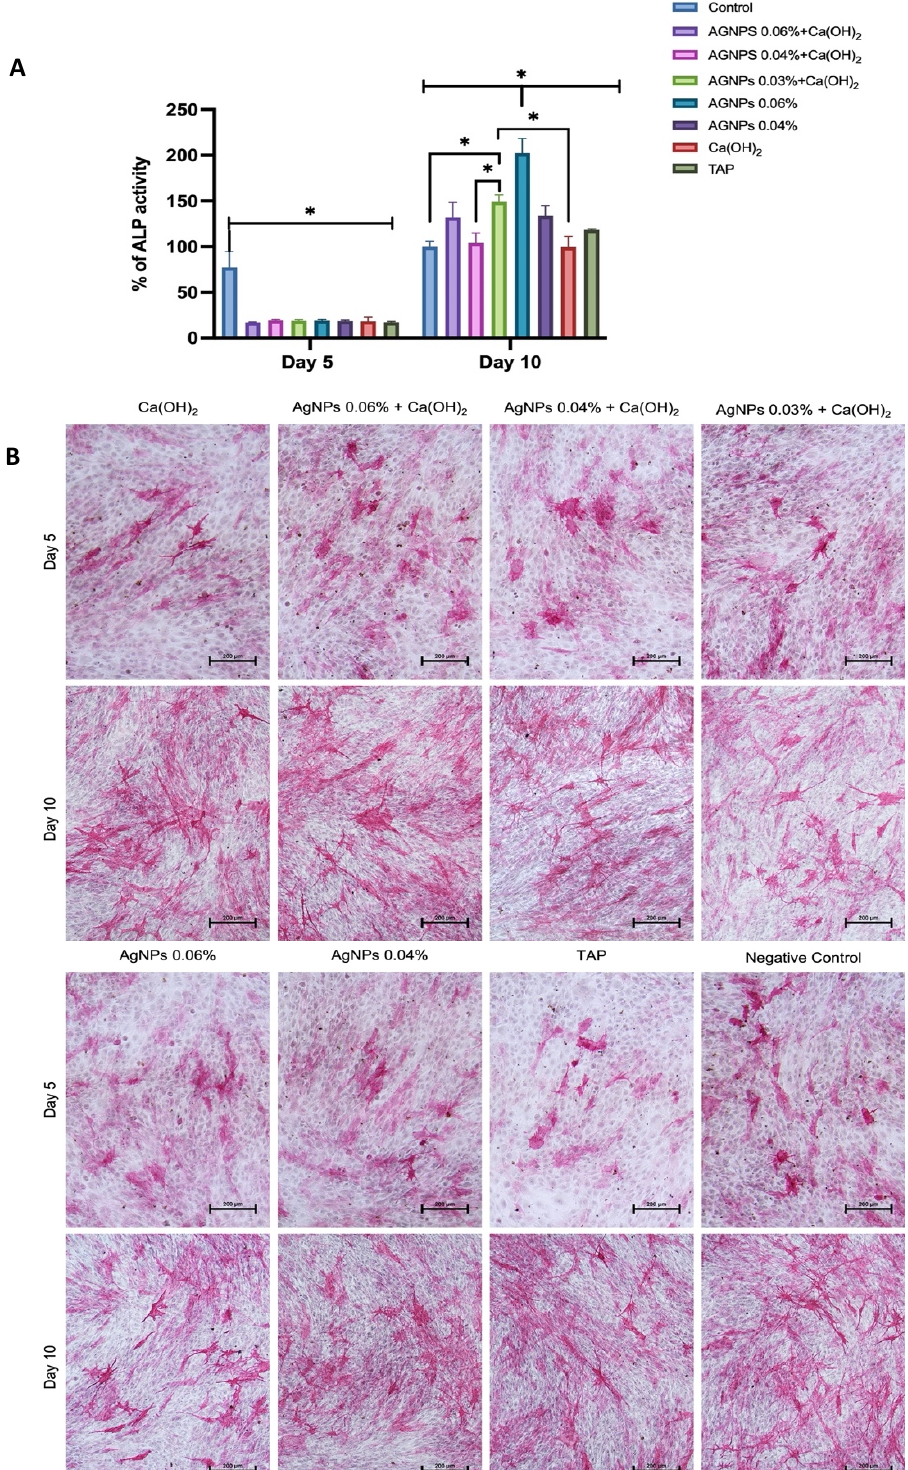
Figure 10. ( A ): Quantification of ALP activity in treated-hBMSCs on days 5 and 10 of osteoblastic differentiation. Control is cells in osteogenic medium. Data are presented as mean percentage of ALP activity ± SEM. Asterisks (*) indicate statistical significance ( p < 0.05). ( B ): Representative alkaline phosphatase (ALP) staining of hBMSCs treated with the test medicaments, images were taken on days 5 and 10 of osteoblastic differentiation. [Ca(OH) 2 : Calcium hydroxide, AgNPs: Silver nanoparticles, TAP: Triple antibiotic paste] .